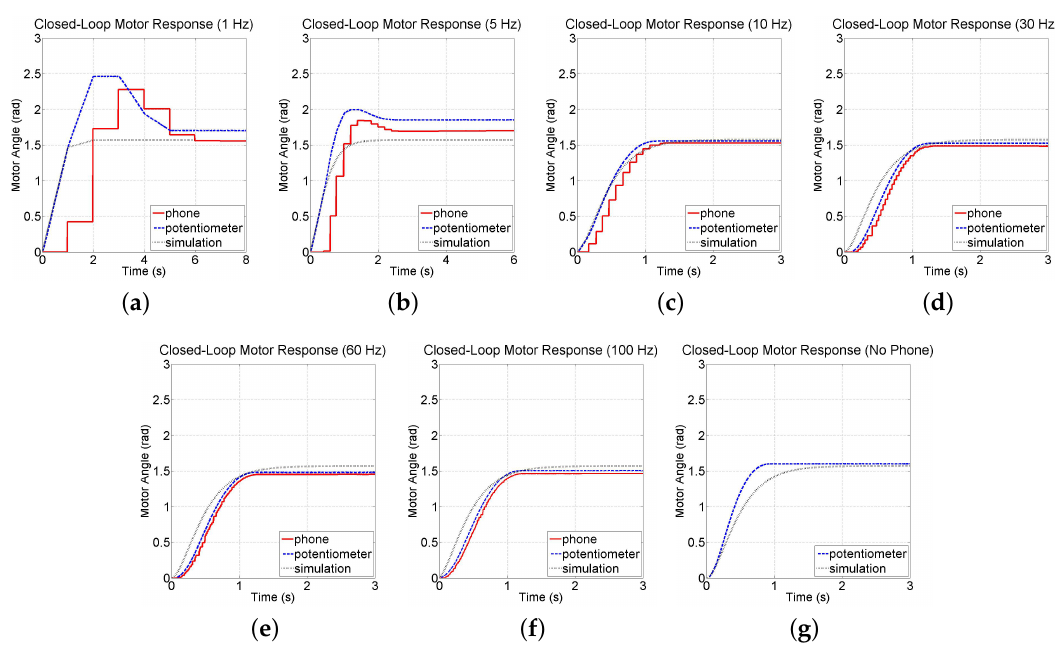
Figure 12. Closed-loop responses of the motor test-bed using the sensors from the ( a – f ) smartphone at various sampling rates and ( g )